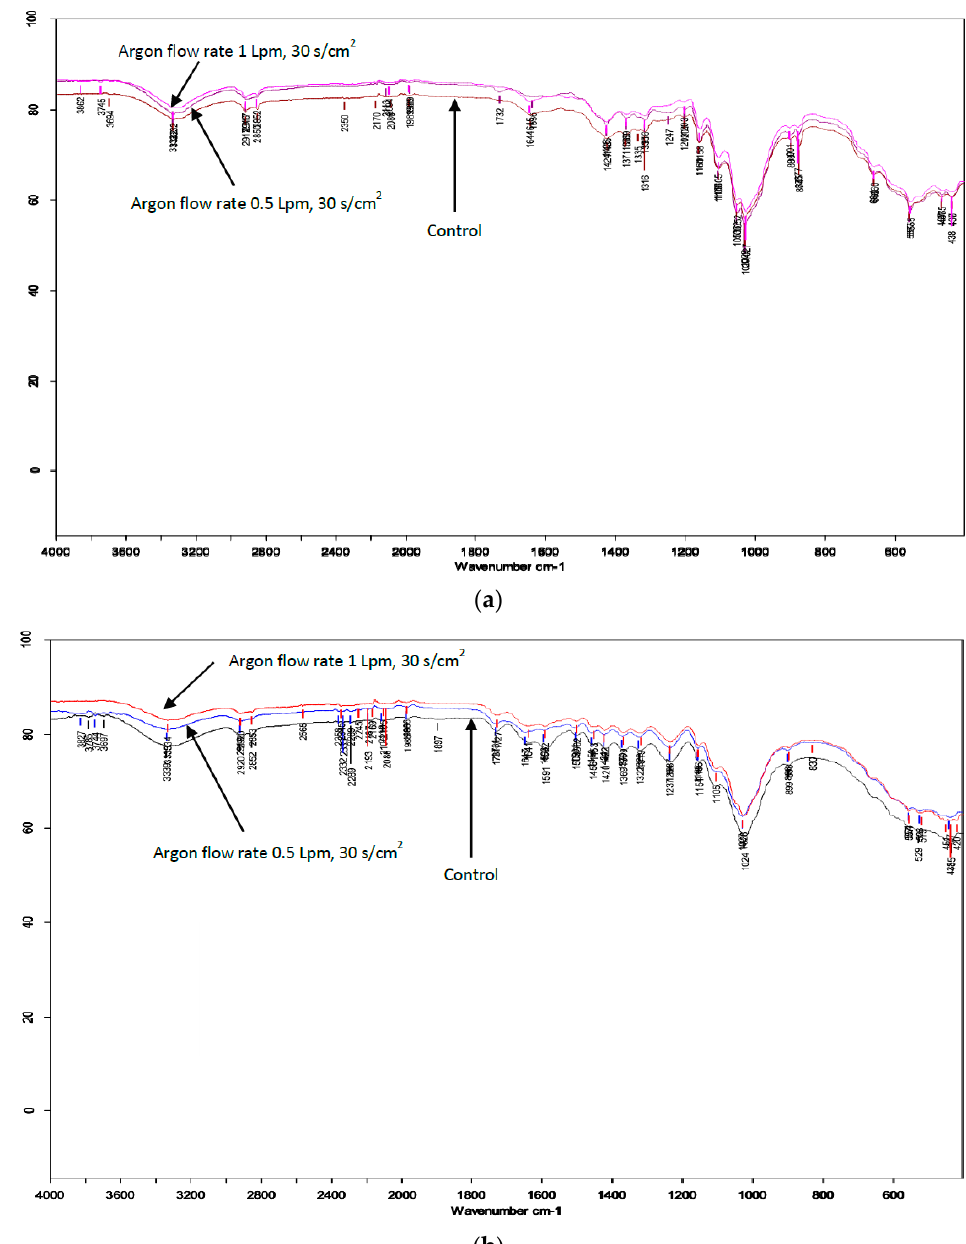
Figure 5. FTIR spectra of cardboard ( a ) and drawing board ( b ) after plasma